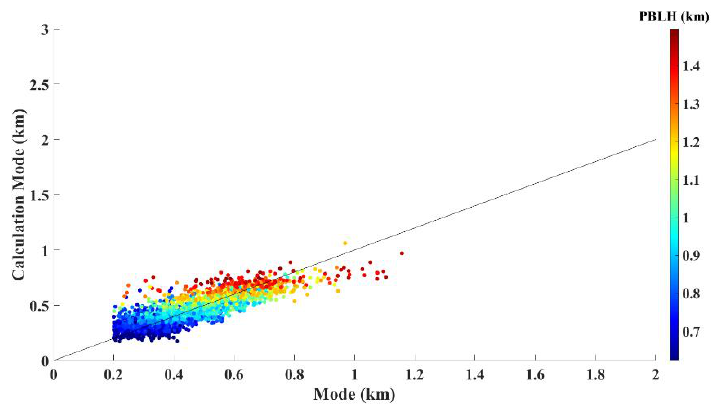
Figure 6. Comparison of the fitted Mode and calculated Mode (CMode) after applying the screening of profiles over a PLBH of 1.5 km. The PBLH values are denoted by the color scale.